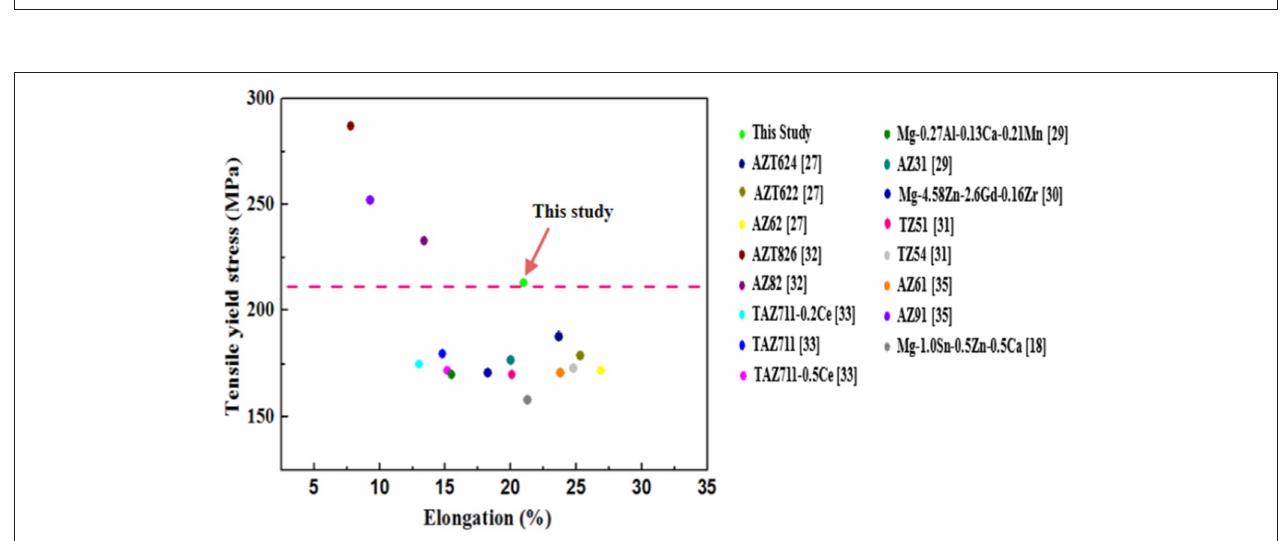
Frontiers in Materials |